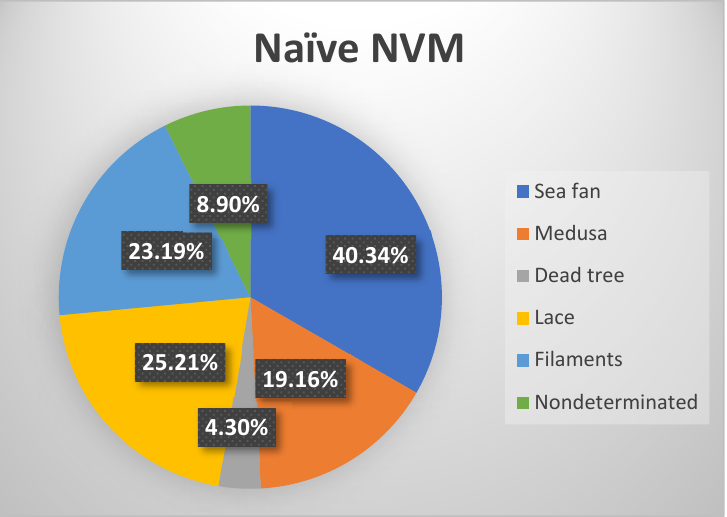
Figure 2. Percentage of naïve morphological type of NVM.